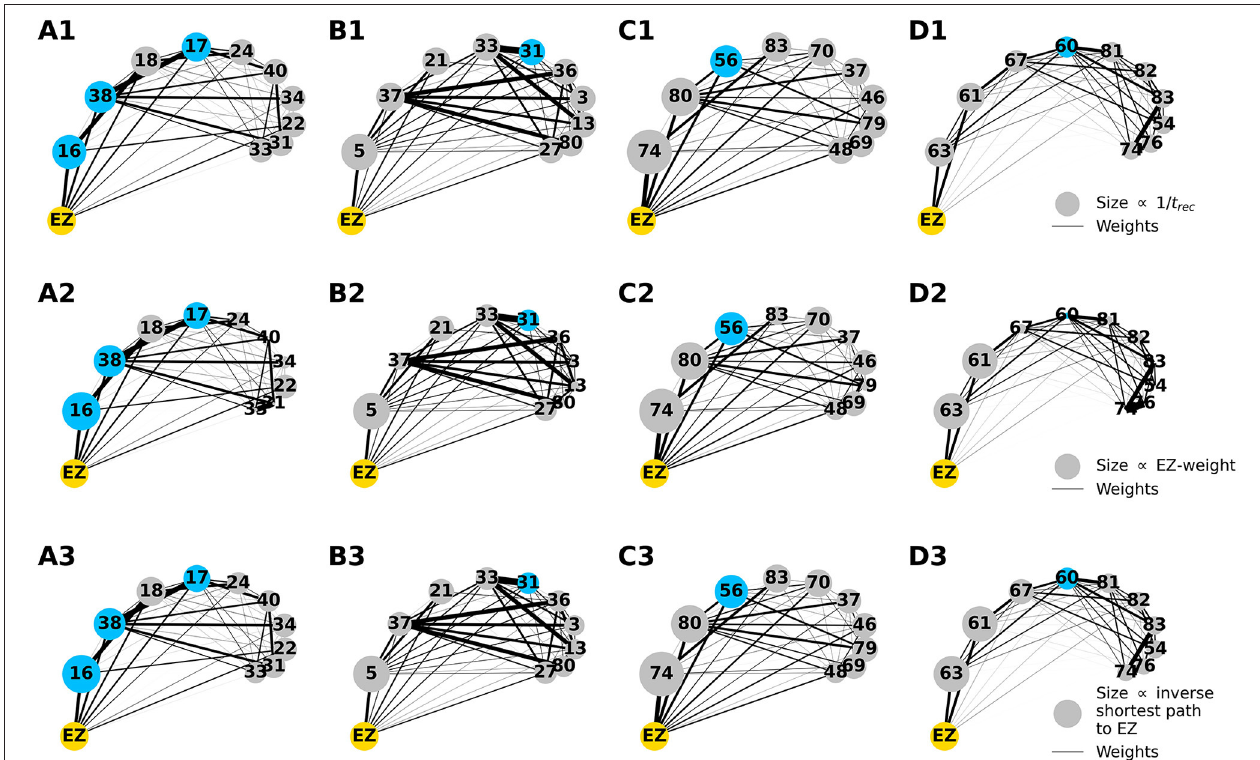
FIGURE 12 | Graph plot of the first 10 recruited areas, ordered clockwise according to their recruitment times, as found via numerical experiments. Node circle size corresponds to the inverse recruitment time (A1–D1) , to the connection strength to the EZ (A2–D2) , and the inverse shortest path length to the EZ (A3–D3) . The size of the yellow EZ remains fixed. Blue dots distinguish a recruited area to belong to the PZ SEEG , i.e., the PZ identified according to the presurgical invasive evaluation. Results are obtained for patients E2 (A1–A3) , E3 (B1–B3) , E6 (C1–C3) , and E13 (D1–D3) . Parameters as in Figure 10